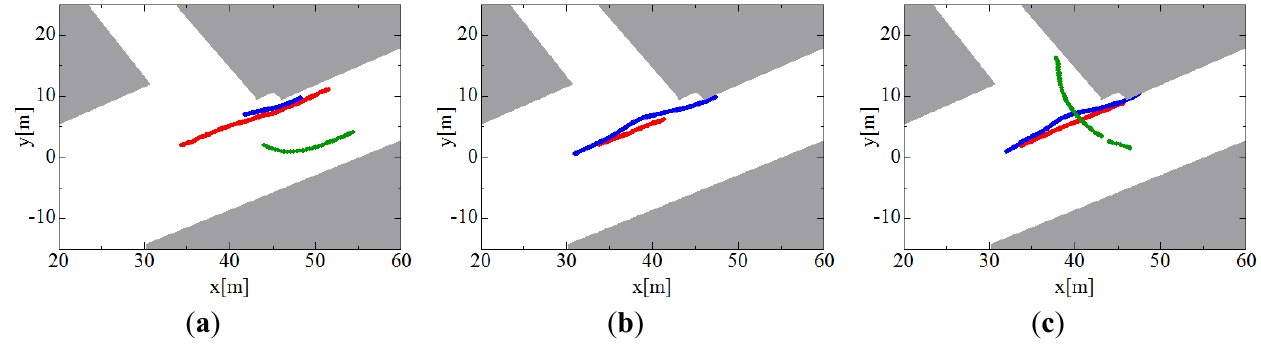
Figure 11. Pedestrian tracks estimated by individual tracking. ( a ) Robot #1. ( b ) Robot #2. ( c ) Robot #3. Red, blue and green lines indicate paths of pedestrians #1, #2 and #3, respectively.